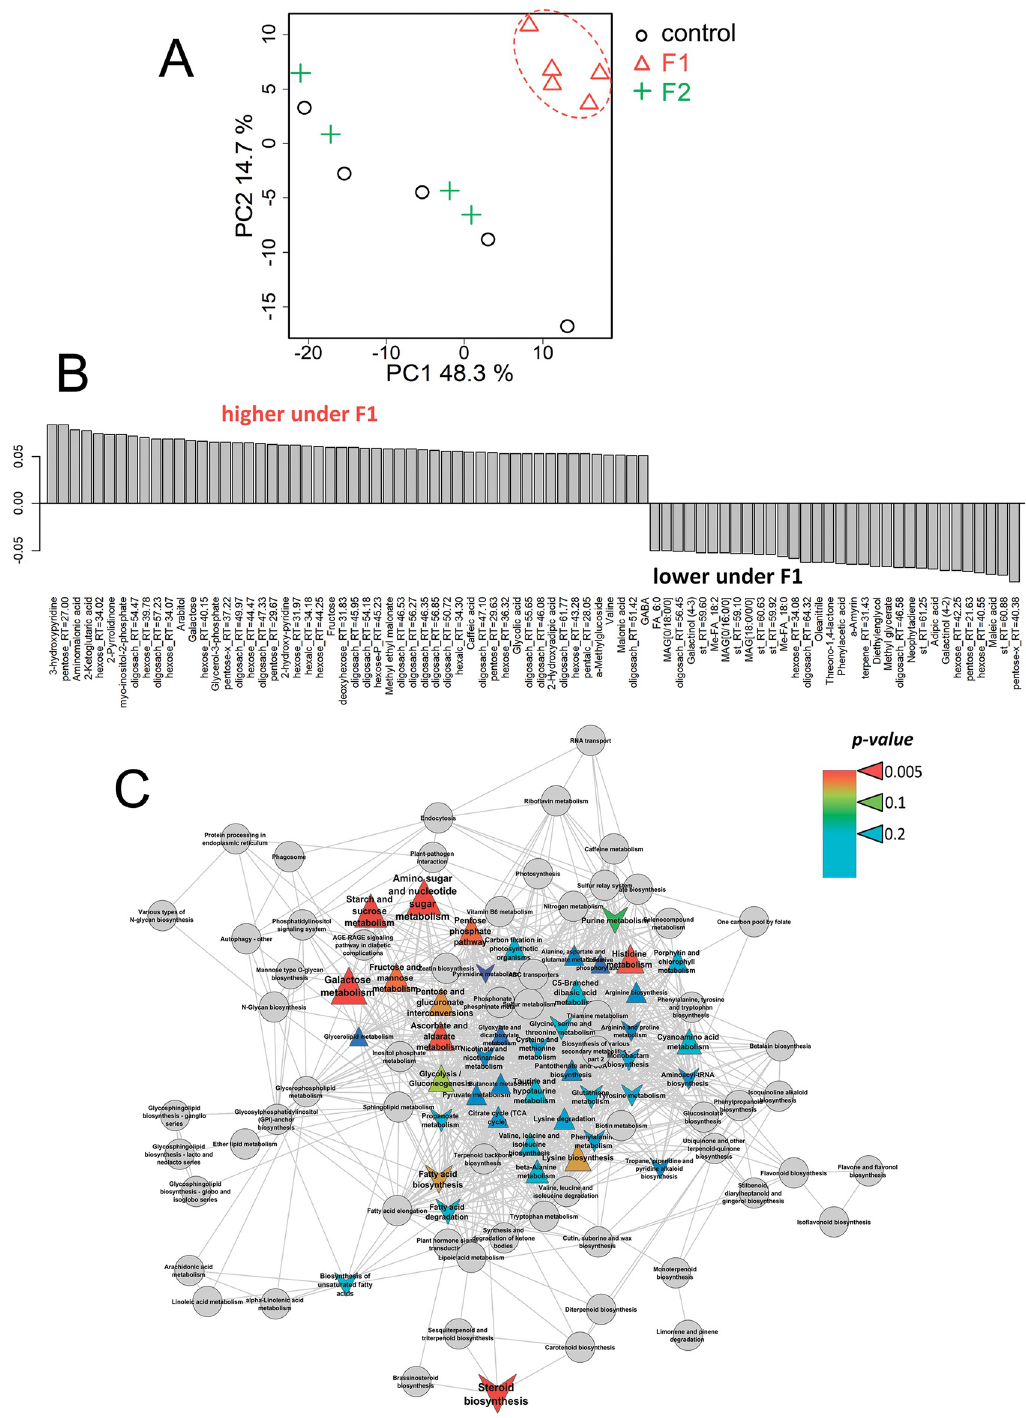
Fig 4. Fullerenol effects on leaf metabolome of the Fe III -sufficient cucumber plants grown hydroponically in a nutrient solution with or without the supply of 1 (F1) mg L -1 fullerenol for 10 days. A—PCA score plot, B—Bar plots of loadings of predictive component (VIP > 1) derived from OPLS-DA, C—Enrichment analysis. Colours represent p- value, shapes: Δ — activation induced by F1, v—repression by Fq, sizes: The power of effect represented as |NES|.